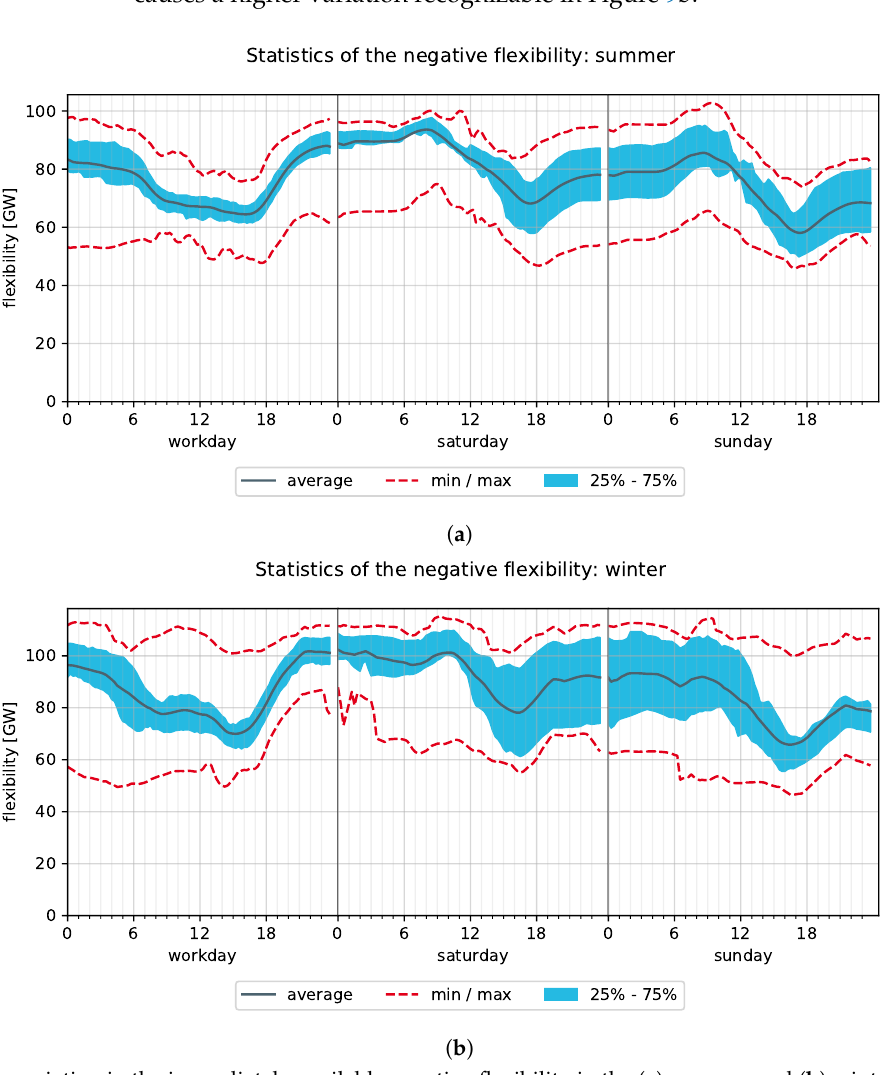
Figure 9. Daily variation in the immediately available negative flexibility in the ( a ) summer and ( b ) winter of the year 2030. The potential positive flexibility depicted in Figure 10 appears to be less volatile for both summer and winter months. At the same time, the spikes of the maximal flexibility stand out. The presented min. and max. values are the combined min. and max. values of all considered days. Spikes can be caused by low prices and/or weather events of single days. Zig-zag behavior as seen in Figure 10b is usually the result of spikes during multiple days. They occur in the early morning workdays, and they occur on weekends in the morning and around noon. Those spikes can be mainly explained by low electricity prices; due to an independent charging management, the EVs utilize this in their optimized charging schedule and start to charge with high power at the same time. Many cars drop out shortly after due to fully charged batteries. Stopping the charging process (unidirectional) or even discharging the battery to provide positive flexibility leads to the spikes present in both seasons. The spikes are less evident during the summer months since the EVs are optimized to charge using PV power, thus, drawing less power from the